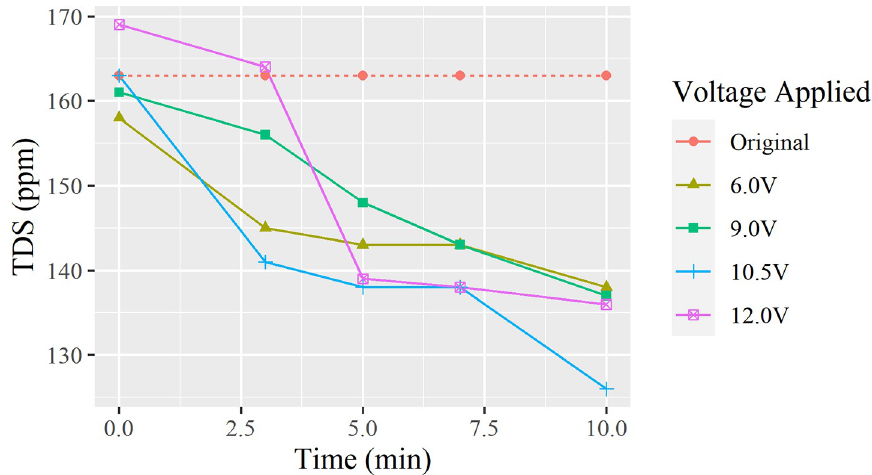
Fig 10. TDS changes with different electrical